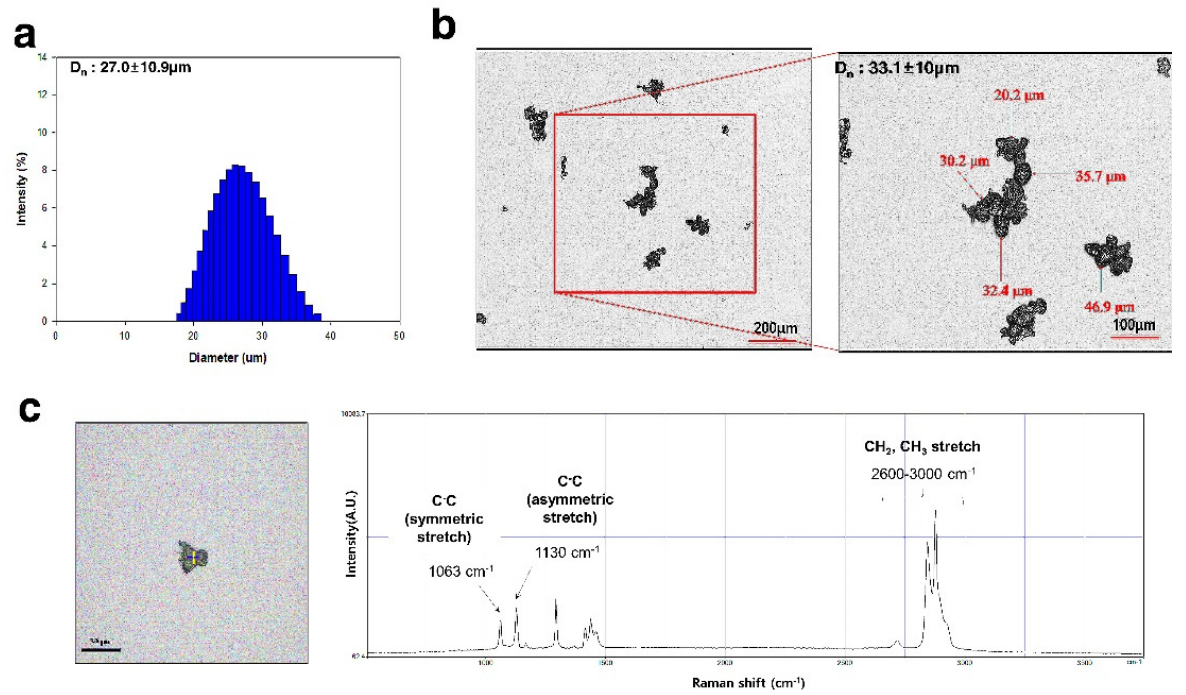
Figure 1. Characteristics of polyethylene microplastics. ( a ) Diameter size of polyethylene microplas- tics dispersed in ethanol was determined by PSA. ( b ) Shape of polyethylene microplastics were de- termined by confocal microscopy (Scale bar: 200 and 100 μ m). ( c ) Raman spectrum of microparticles filtered on a silicon filter. Scale bar = 50 μ m.